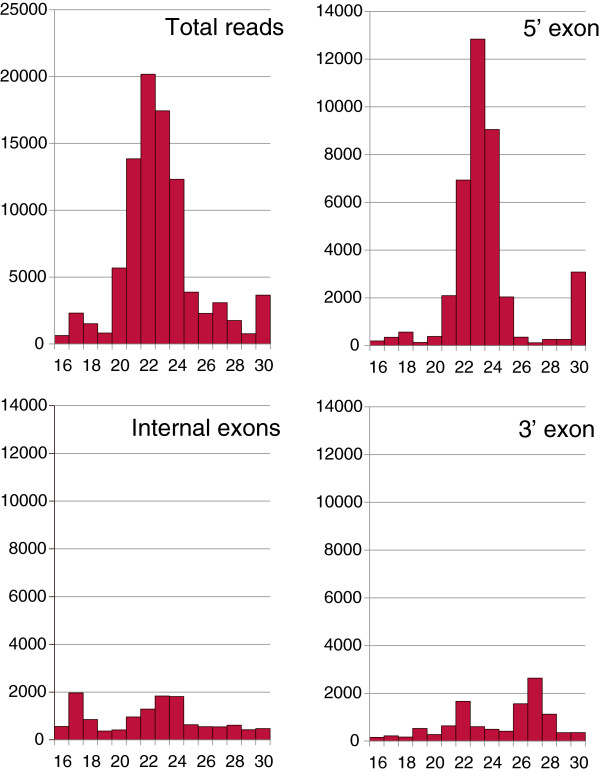
Length signature of endo-siRNAs intersecting with AGO1 CLASH reads. Diagrams show the total reads (upper left) binned according to their length (16-30 nucleotides), reads in the first exon (upper right), in internal exons (lower left) and in the last exon (lower right) of genes.